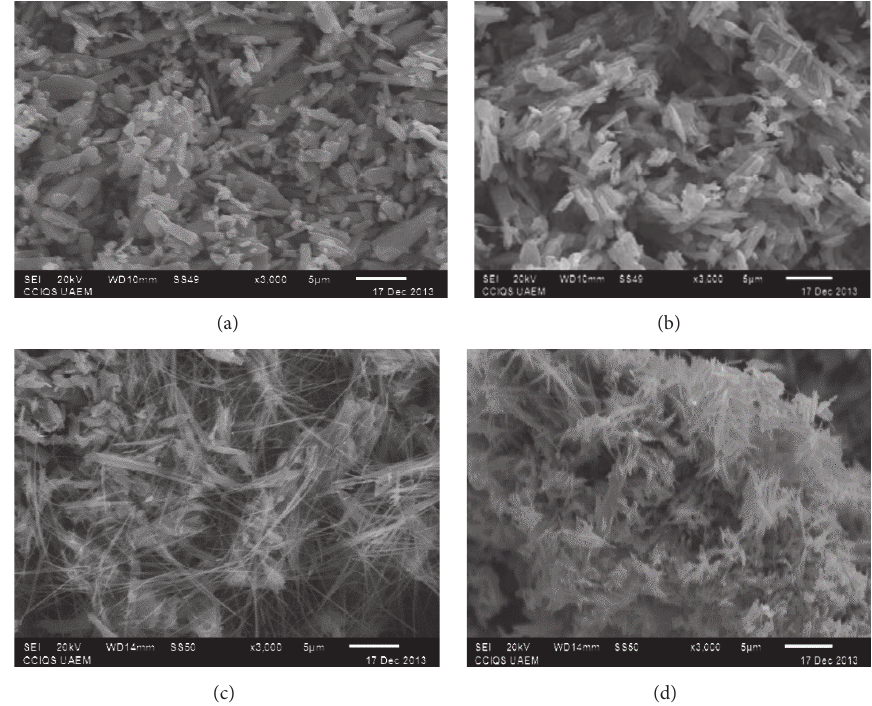
Figure 2: Scanning electron microscopy images at 3000x of (a) V 2 O 5 , (b) V 2 O 5 -5Ag, (c) V 2 O 5 -10Ag, and (d) V 2 O 5 -20Ag photocatalysts.